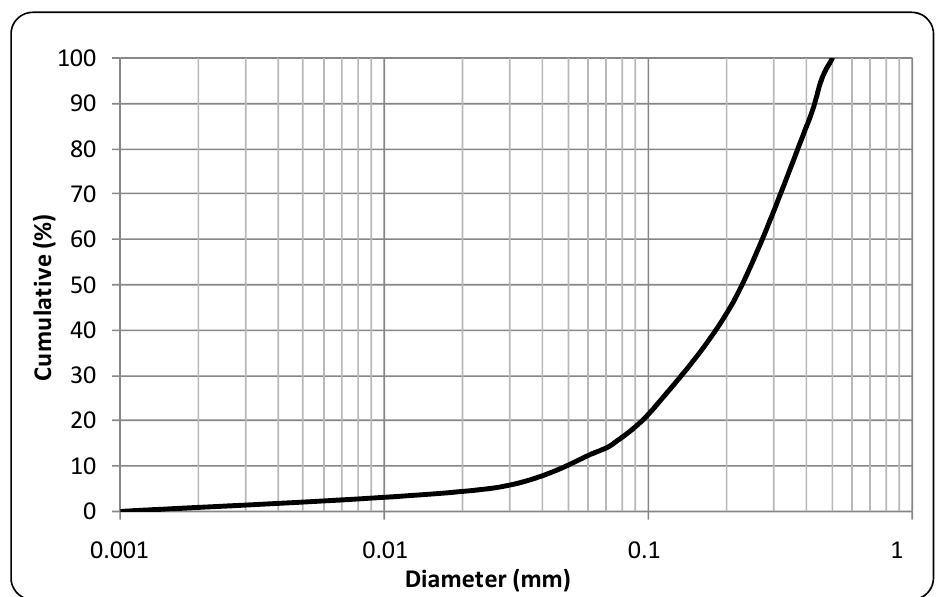
Figure 3. Particle size distribution of gypsum plaster.